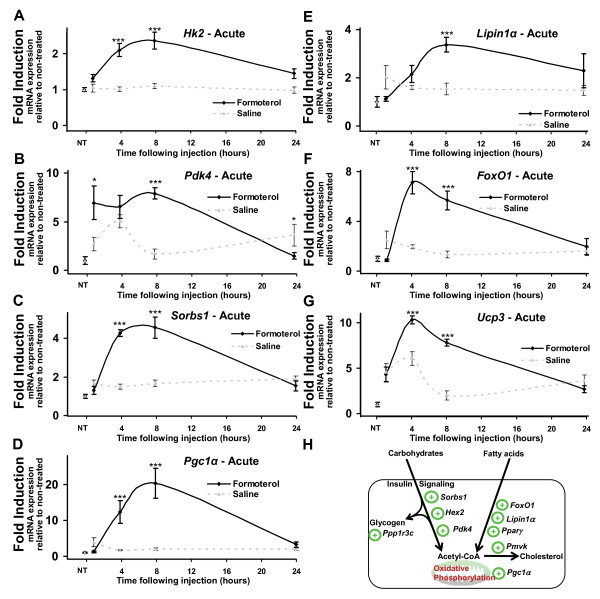
Acute systemic administration of formoterol alters the expression of genes associated with metabolism. Quantitative RT-PCR was used to assay the expression of A. Hk2, B. Pdk4, C. Sorbs1, D. Pgc1α, E.Lipin1α, F. FoxO1, and G.Ucp3 mRNAs in tibialis anterior over acute timepoints. Muscles were removed at 1, 4, 8 and 24 hours following a single intraperitoneal injection of formoterol or saline vehicle (NT = no treatment). Results were normalized against 36B4 at each timepoint. Statistical significance was assessed using a one-way ANOVA with Bonferroni's post-test where p < 0.05 (*), p < 0.01 (**) and p < 0.001 (***). Unmarked data points are non-significant. G. Diagrammatic representation of acute gene expression changes related to metabolic in skeletal muscle in response to formoterol.